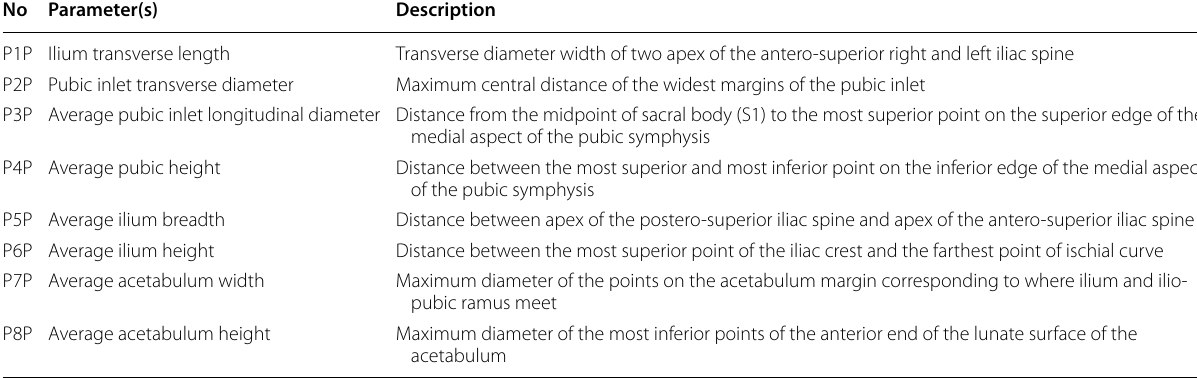
Table 4 Definition and description of pelvic girdle parameters modified based on Lia et al.